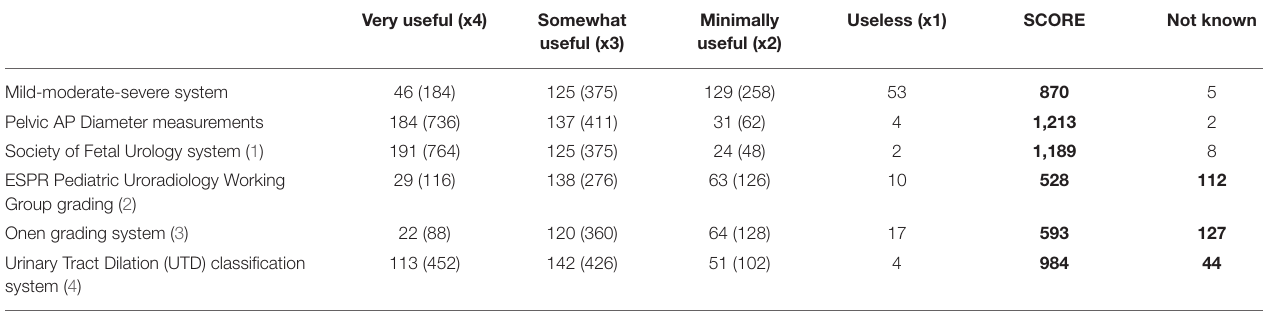
TABLE 2 | Opinion of the responders of each system.